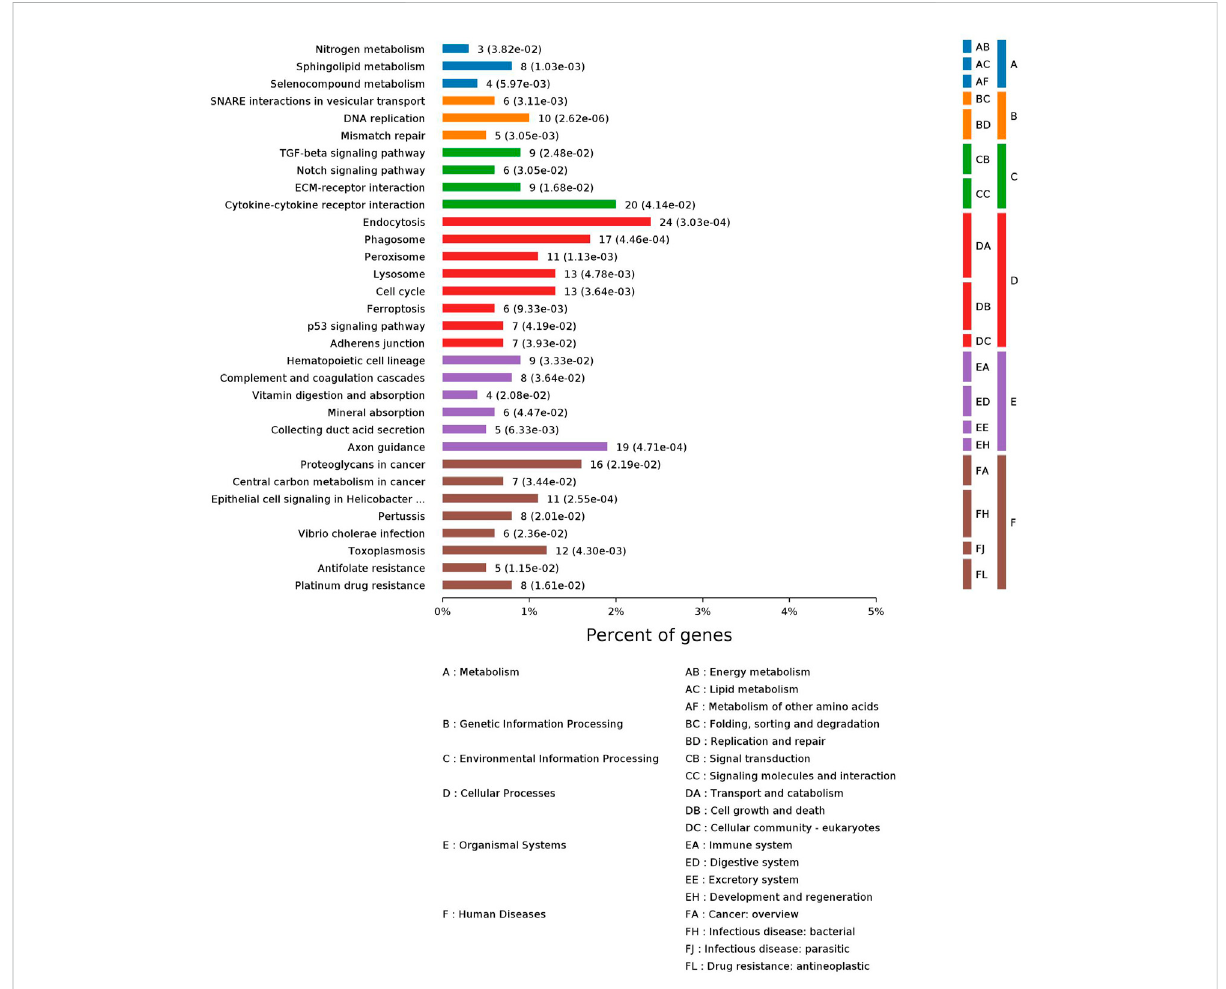
FIGURE 6 KEGG pathway enrichment analysis of those 1,073 signi fi cantly changed proteins. Each column represented one pathway, whose height indicated the number of different metabolites